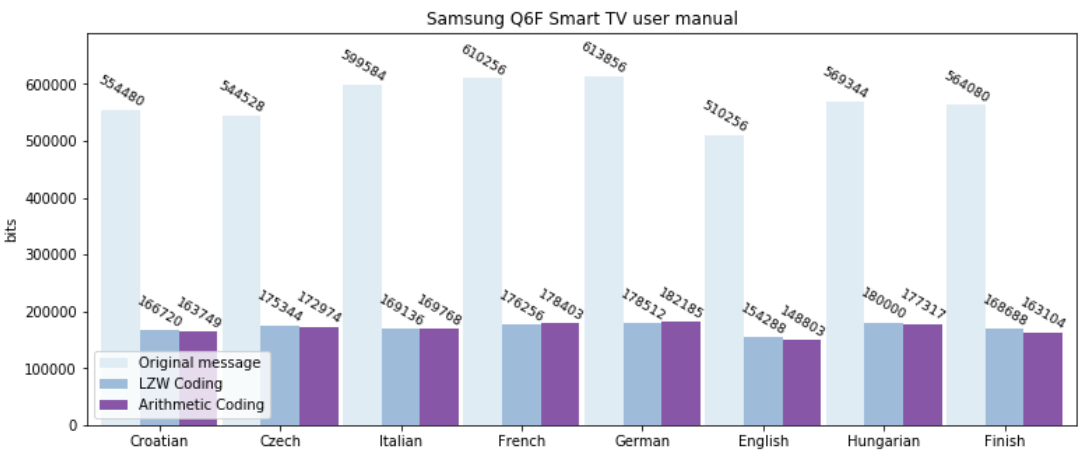
Figure 8. Encoding Samsung Q6F Smart TV user